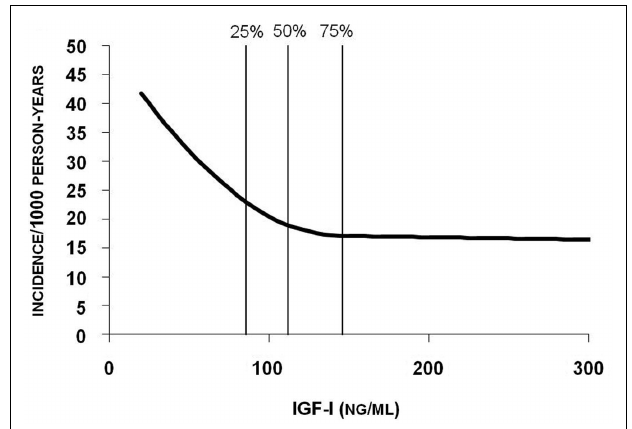
FIGURE 1 |Yearly incidence of fracture in relation to serum IGF-1. Poisson regression models were used to determine the relation between serum IGF-1 levels and risk of fractures.The quartile limits (25, 50, and 75%) are indicated by vertical lines in the figure. Reproduced from Ohlsson et al. (2011) with permission of the American Society for Bone and Mineral